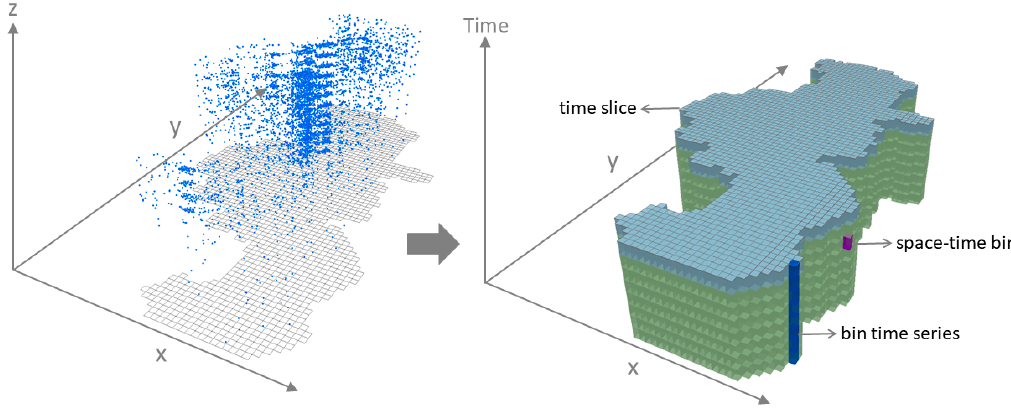
Figure 5. An example of a space-time cube.